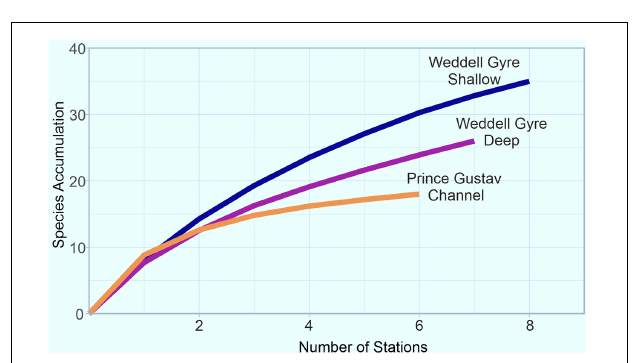
FIGURE 5 | Species accumulation across number of stations for the Weddell Gyre (WG) region divided into three groups: WG-shallow, WG-deep, and Prince Gustav Channel